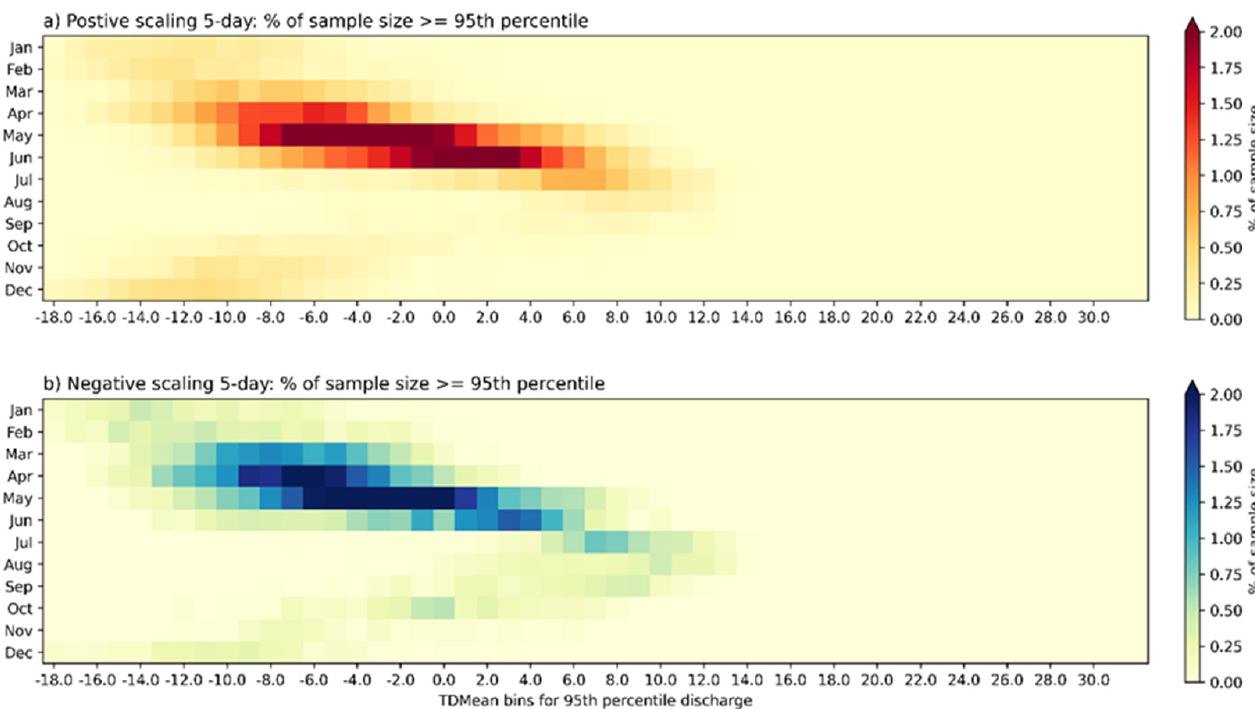
Figure A5. As in Figure 6 except scaling with 5-day running mean dewpoint temperature.